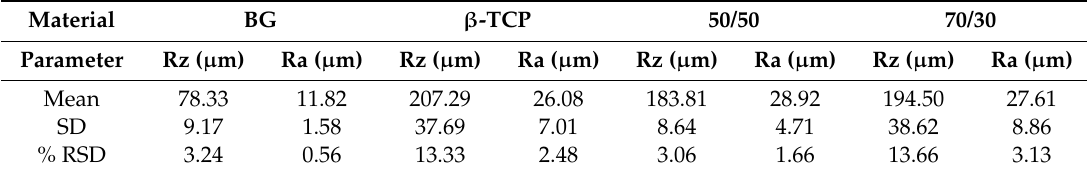
Table 3. Surface Roughness of the 3D printed Scaffolds (selected parameters) ( n = 10).